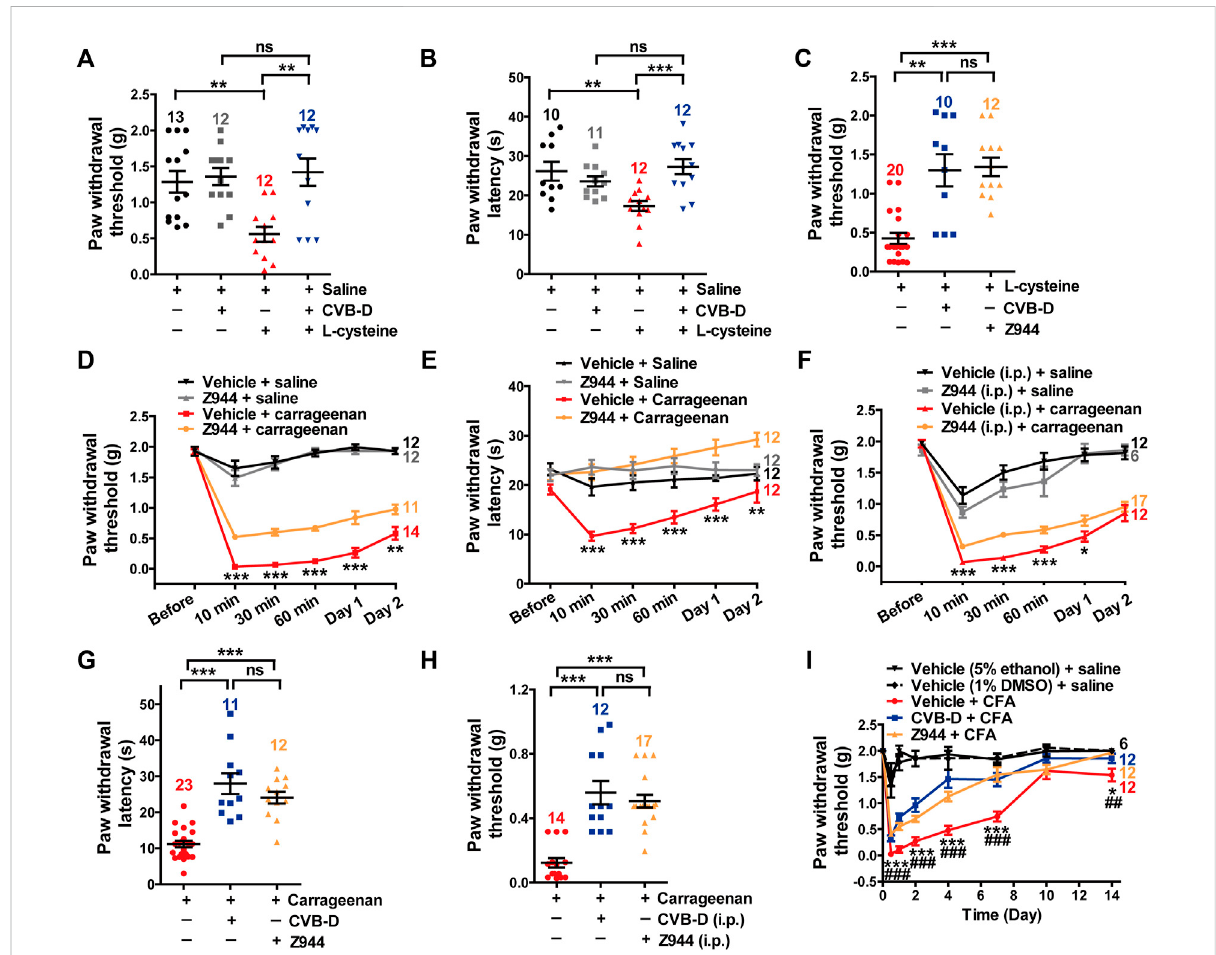
FIGURE 6 MajorroleofCa v 3.2intheanalgesiceffectsofCVB-Dinmousemodels. (A) EffectofCVB-Don L -cysteine-inducedmechanicalhypersensitivity. Saline (black) was used as a control for L -cysteine (red), and vehicle (gray) was used as a control for CVB-D (blue). PWT was measured with von Frey fi laments at 10 min after i. pl. injection of saline (black), CVB-D (gray), and L -cysteine (red and blue). (B) Effect of CVB-D on L -cystetine-induced thermal hypersensitivity. Same grouping and experimental procedures as in A, except that PWL was measured by the hot plate assay. (C) Comparison of the analgesic effect of CVB-D and Z944 on L -cystetine-induced mechanical hypersensitivity. (D) Effect of Z944 (i.pl. injection) on carrageenan-induced mechanical hypersensitivity. Same experimental procedures as in Figure 1G, except that Z944 (3.84 μ g/paw, orange) was intraplantarly injected 30 min prior to carrageenan injection (red). Vehicle-saline (black) was used as a control for vehicle-carrageenan (red). Z944- saline (gray) was used as a control for Z944-carrageenan (orange). Statistical analysis was performed between the groups of Z944-carrageenan and Vehicle-carrageenan. (E) Effect of Z944 (i.pl. injection) on carrageenan-induced thermal hypersensitivity. Same experimental procedures as in Figure 6D. Statistical analysis was performed between the groups of Z944-carrageenan (orange) and Vehicle-carrageenan (red). (F) Effect of Z944 (i.p. injection) on carrageenan-induced mechanical hypersensitivity. Same experimental procedures as in Figure 6D, except that Z944 (1 mg/kg, orange) and its corresponding vehicle (gray) wereintraperitoneally injected 30 min prior to the injection of carrageenan (red). Statistical analysis was performed between the groups of Z944-carrageenan and Vehicle-carrageenan. (G) Comparison of the analgesic effect of CVB-D and Z944 (both i. pl. injection) on carrageenan-induced thermal hypersensitivity at 30 min after carrageenan treatment. (H) Comparison of the analgesic effect of CVB-DandZ944(bothi.p.injection)oncarrageenan-inducedmechanicalhypersensitivityat30 minaftercarrageenantreatment. (I) Comparisonof the analgesic effect of CVB-D and Z944 (both i. pl. injection) on CFA-induced mechanical hypersensitivity. Statistical signi fi cance between the groups of CVB-D-CFA (blue) and Vehicle-CFA (red) was marked by asterisks, and that between the groups of Z944-CFA (orange) and Vehicle-CFA (red) was marked by pound signs. Data information: The number in each graph indicated the number of mice used in each experiment. Statistical signi fi cance was evaluated using two-tailed t -test (for two-group comparisons) or one-way analysis of variance (ANOVA) followed by Tukey ’ s and LSD test (for multi-group comparisons), with * p < 0.05, ** p < 0.01, *** p < 0.001, # p < 0.05, ## p < 0.01, and ### p < 0.001; ns indicates no signi fi cance. The exact t, F, and p -values are indicated in Appendix Table S1. All the data are presented as mean ±